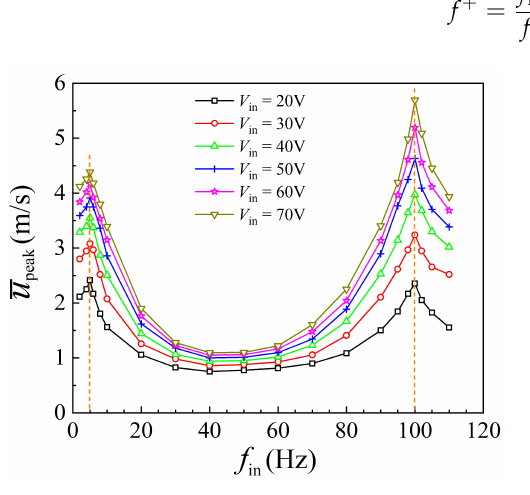
Figure 14. Frequency response of the synthetic jet actuator with pipes.